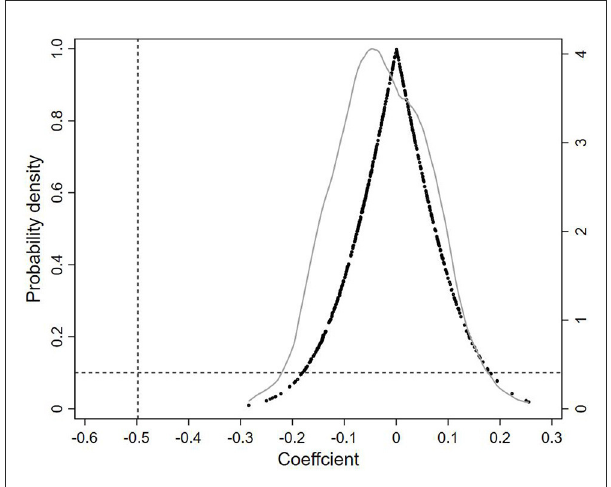
FIGURE2 Results of the kernel density distribution of the DID of the placebo